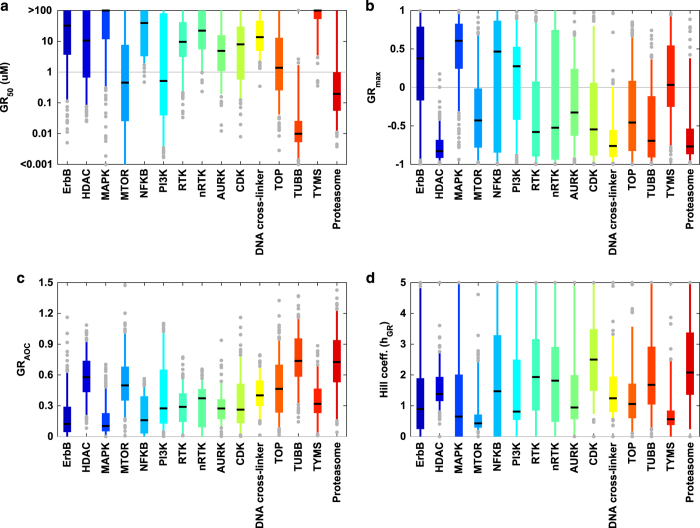
Distribution of the GR metrics by drug class for all analyzed cell line/perturbagen pairs (averaged across biological replicates).(a) GR50 values. (b) GRmax values. (c) GRAOC. (d) Hill coefficient (hGR).